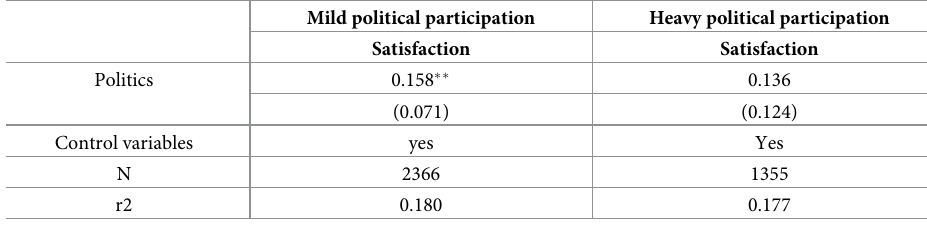
Table 8. Varying degrees of political